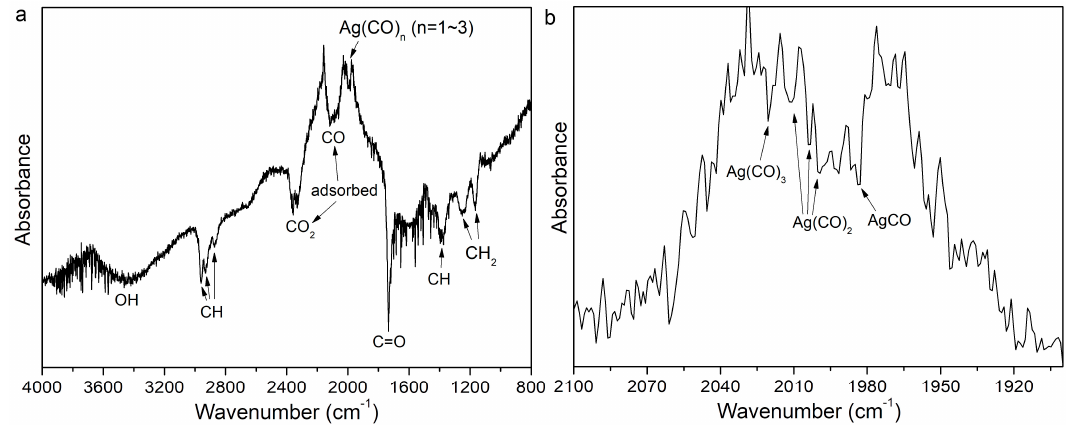
Figure 7. ( a ) FTIR spectrum of the six month aged Ag NPs and the ( b ) magnified spectrum where the peaks of Ag(CO) n (n = 1–3) complexes are located.